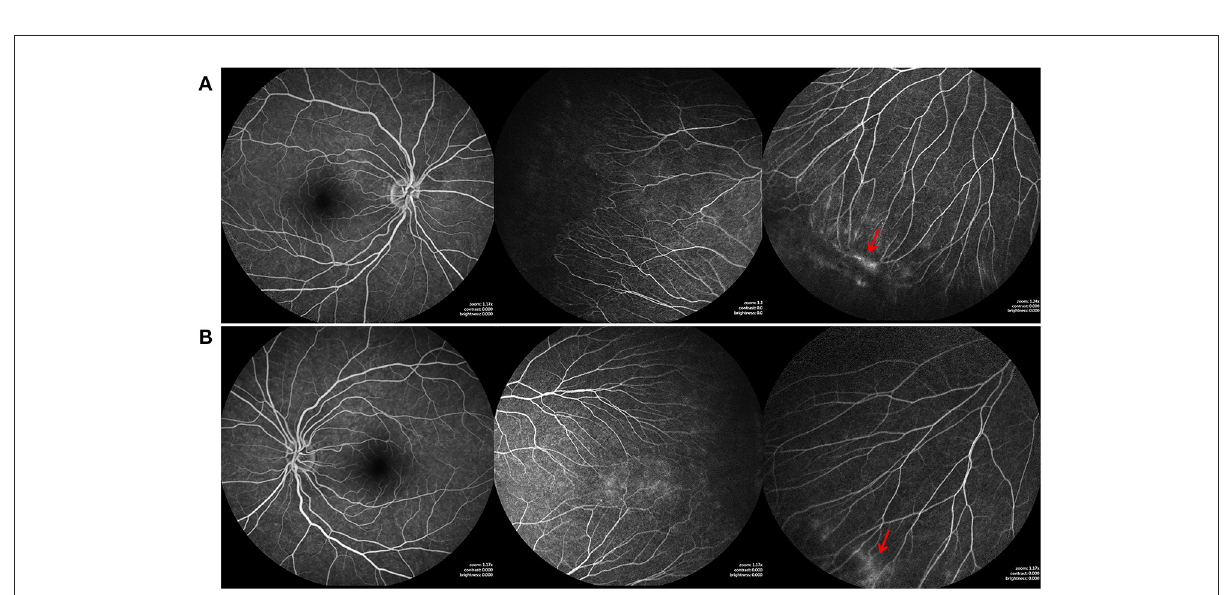
FIGURE3 Fundus fluorescein angiography (FFA) findings of the elder sister of case1, who also carried the FZD4 mutation. (A,B) are bilateral fundus images, showing temporal avascular area with brush-shaped peripheral retinal vessels, avascular retinal periphery and leakage of the dye (red arrow).